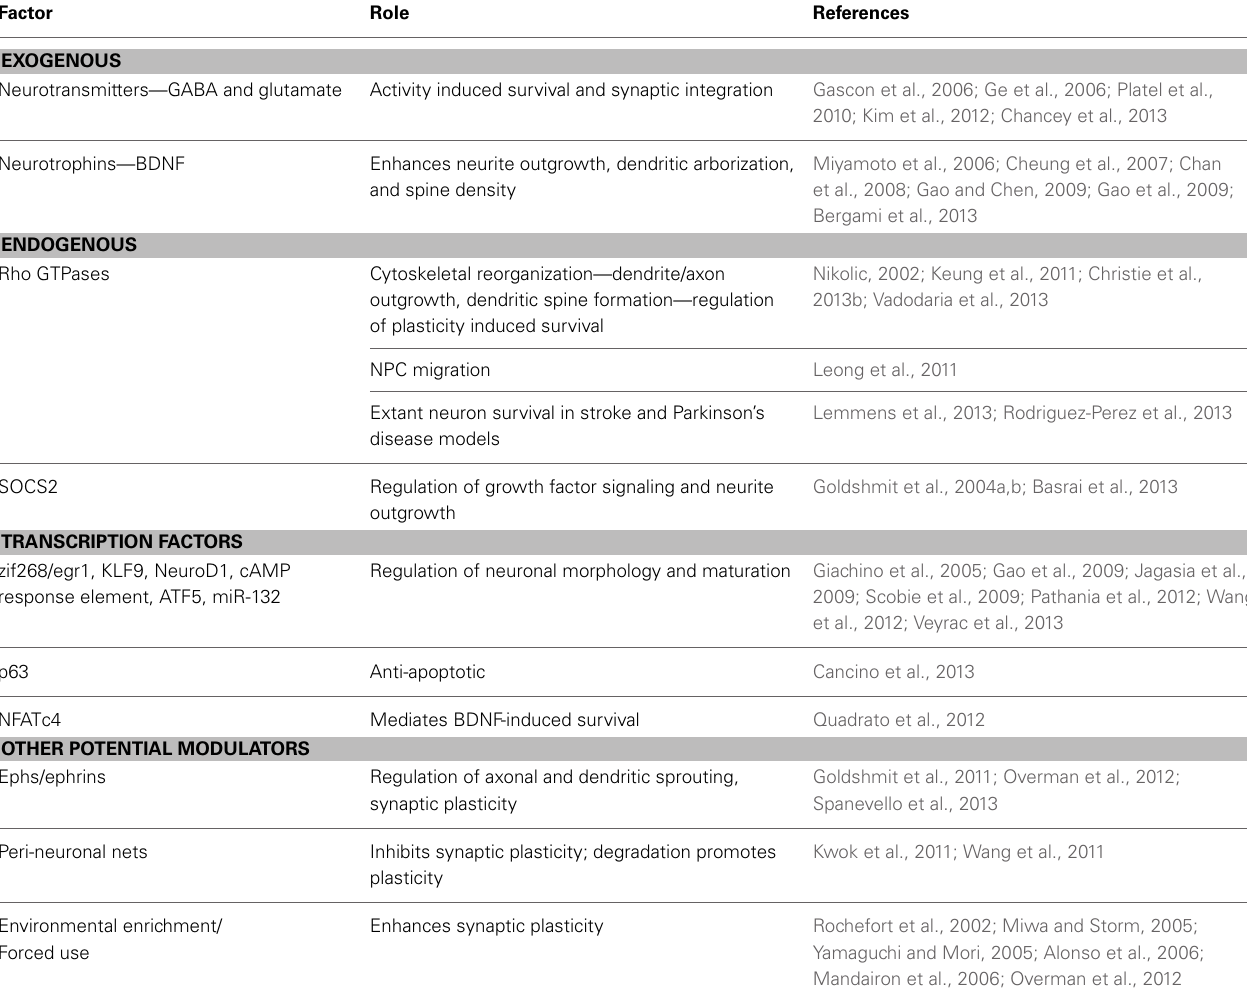
Table 1 | Factors that regulate or may be targeted to promote survival of adult newborn